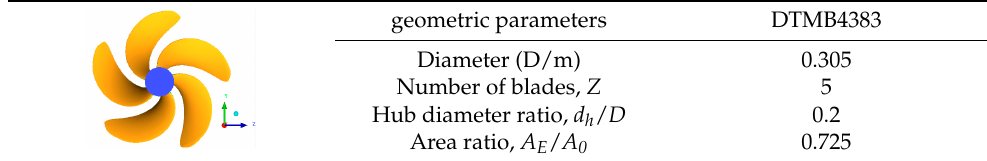
Table 2. Main parameters of DTMB4383. geometric